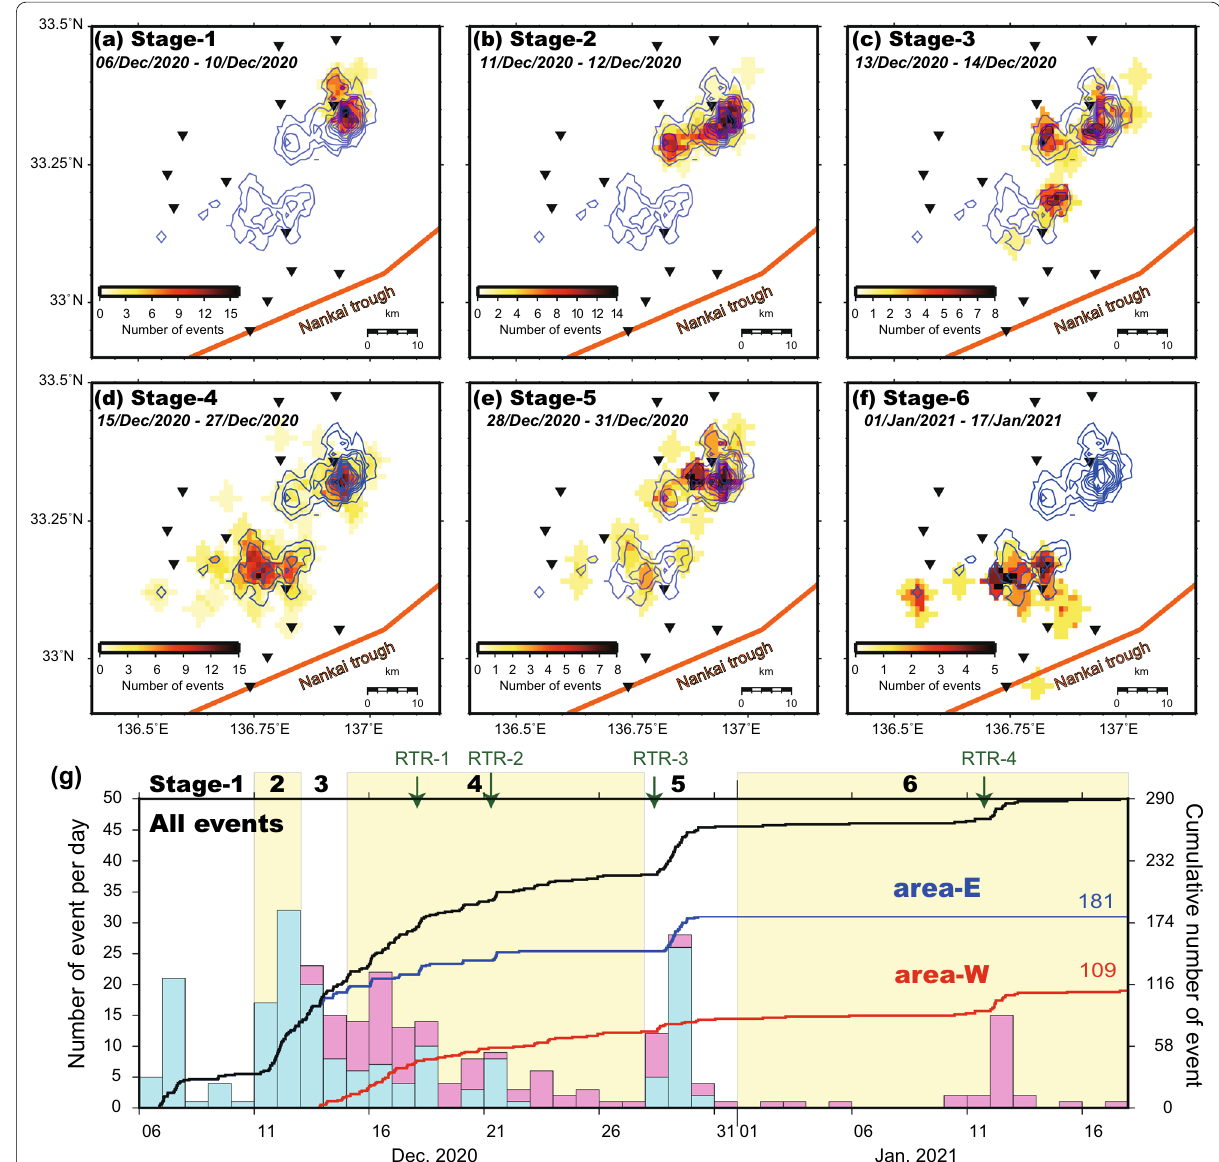
Fig. 4 Heatmap during this sVLFE episode for a Stage 1, b Stage 2, c Stage 3, d Stage 4, e Stage 5, and f Stage 6. Other symbols are the same as in Fig. 2b. g Histogram of the sVLFEs. The height of the bars indicates the number of earthquakes per day, and the colors within the bars indicate the breakdown of the number of sVLFEs by area: eastern (E; sky-blue) and western (W; pink). The black, blue, and red lines are the cumulative number of sVLFEs in all catalogs, the E area, and the W area,